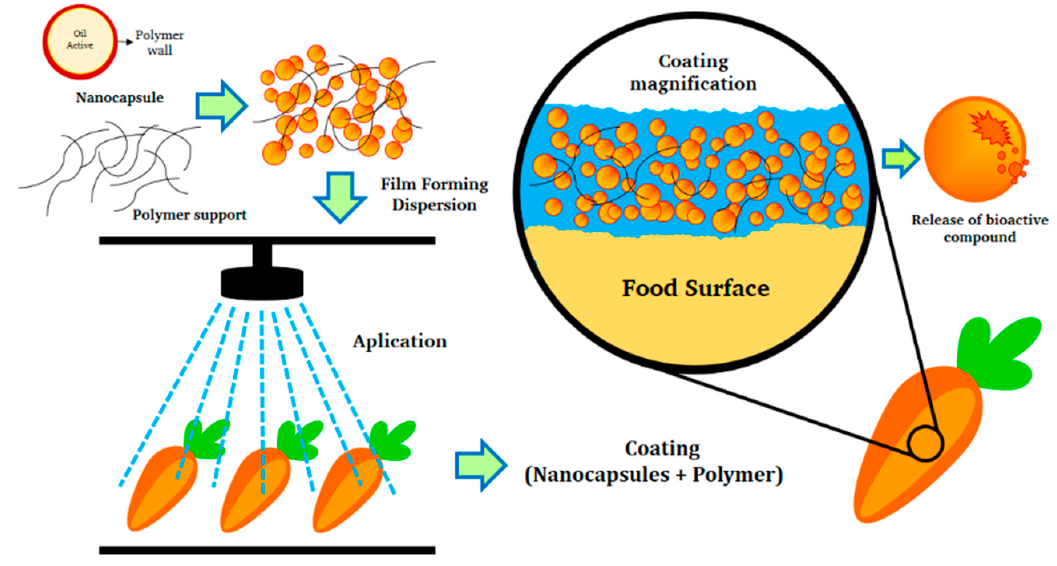
Figure 2. Structure of polymeric nanoparticles in edible coating.